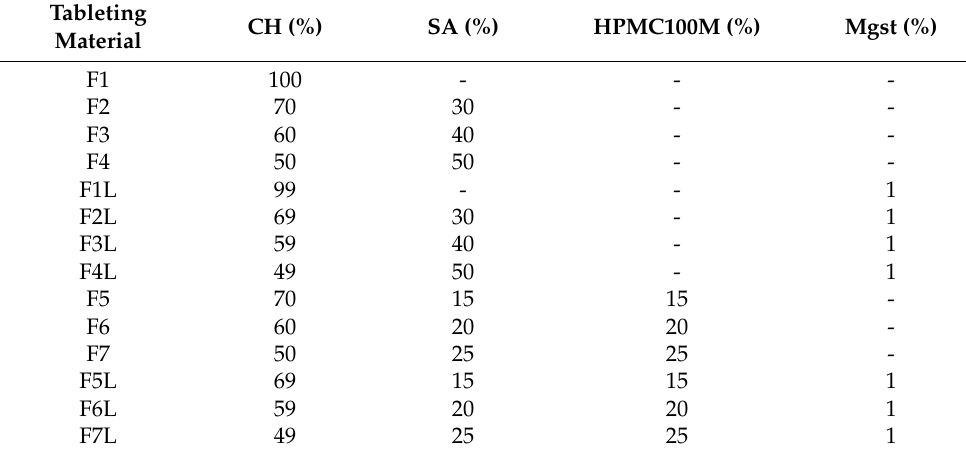
Table 1. Composition of tableting materials with chitosan.